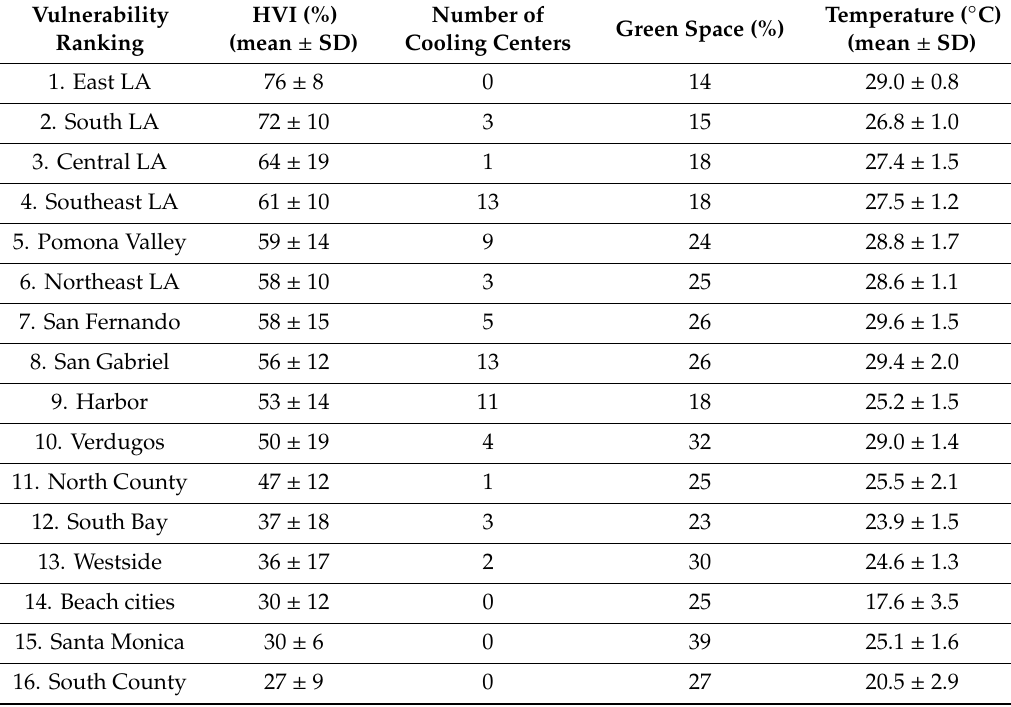
Table 2. The most vulnerable regions in Los Angeles county ranked by mean HVI for the four ECOSTRESS acquisitions from July–August 2018. Also shown are the number of cooling centers, percentage of green space, and average surface temperatures from